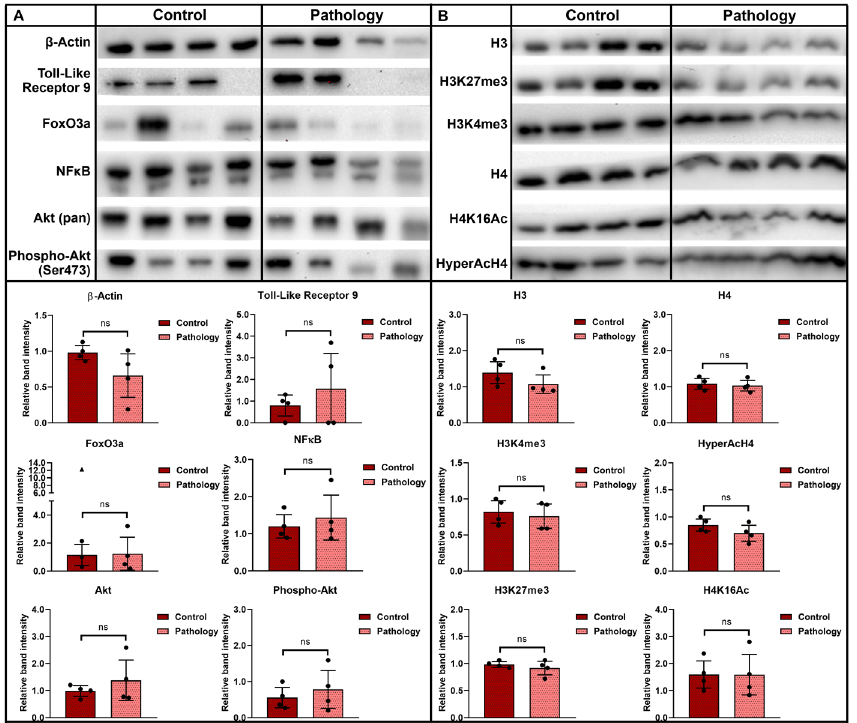
Figure 5. Evaluation of changes in protein levels in the control group and in the pathology group n = 4. ( A ) Proteins of decidualization pathways. ( B ) Histone modifications. Beta-Actin and histones H3 and H4 are control proteins. The intensity of the protein bands was estimated by the ImageJ program, and the levels of each protein were calculated according to the Beta-Actin, Akt, H3, and H4. Densitometric analysis graphs of relative band intensity of detected protein levels was measured using ImageJ software and normalized to the loading control. Results are presented as mean ± standard deviation; triangle data points represent outliers based on ROUT (Q = 5%); ns—not statistically significant, based on the Mann–Whitney U